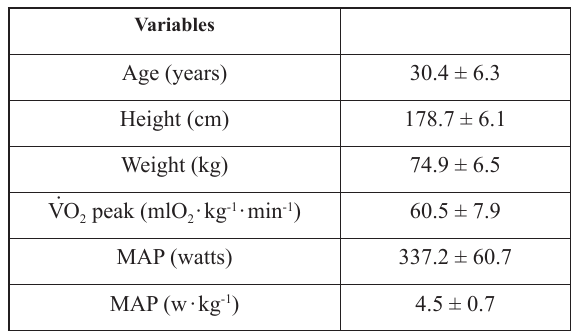
Table 1. Mean descriptive data of study participants